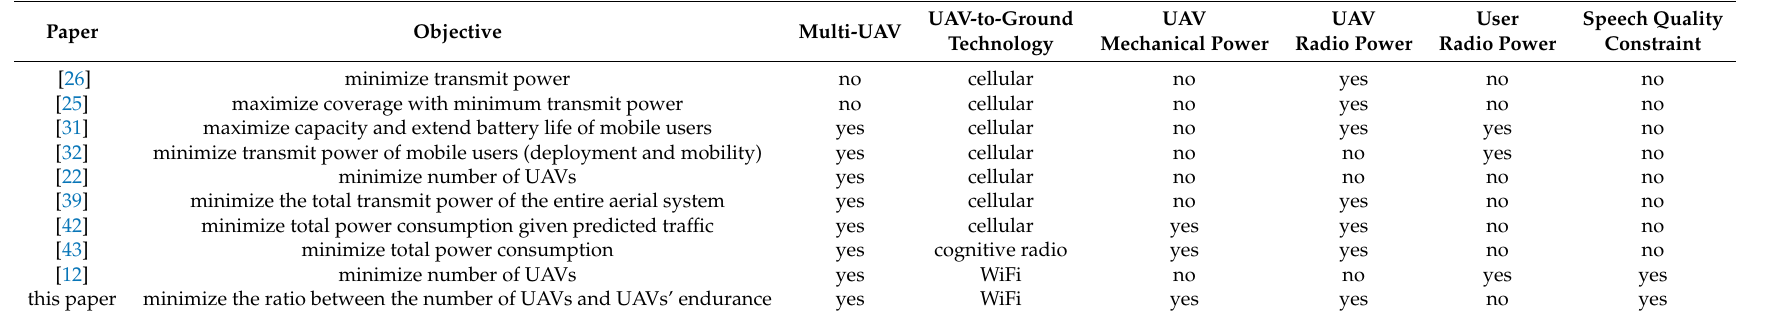
Table 1. Comparison of main works related to 3D optimal placement of UAVs for